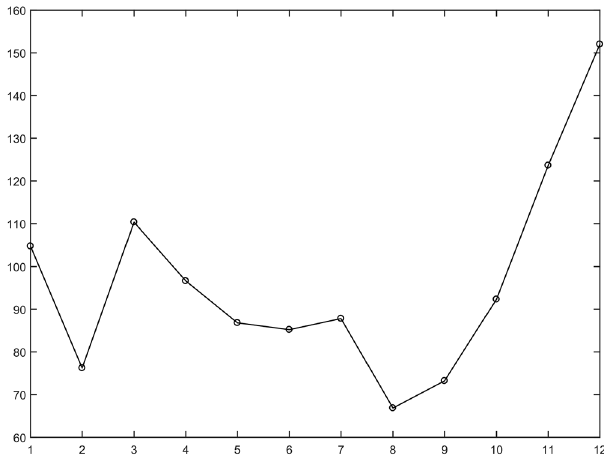
Figure 3. Monthly average AQI values from January to December in